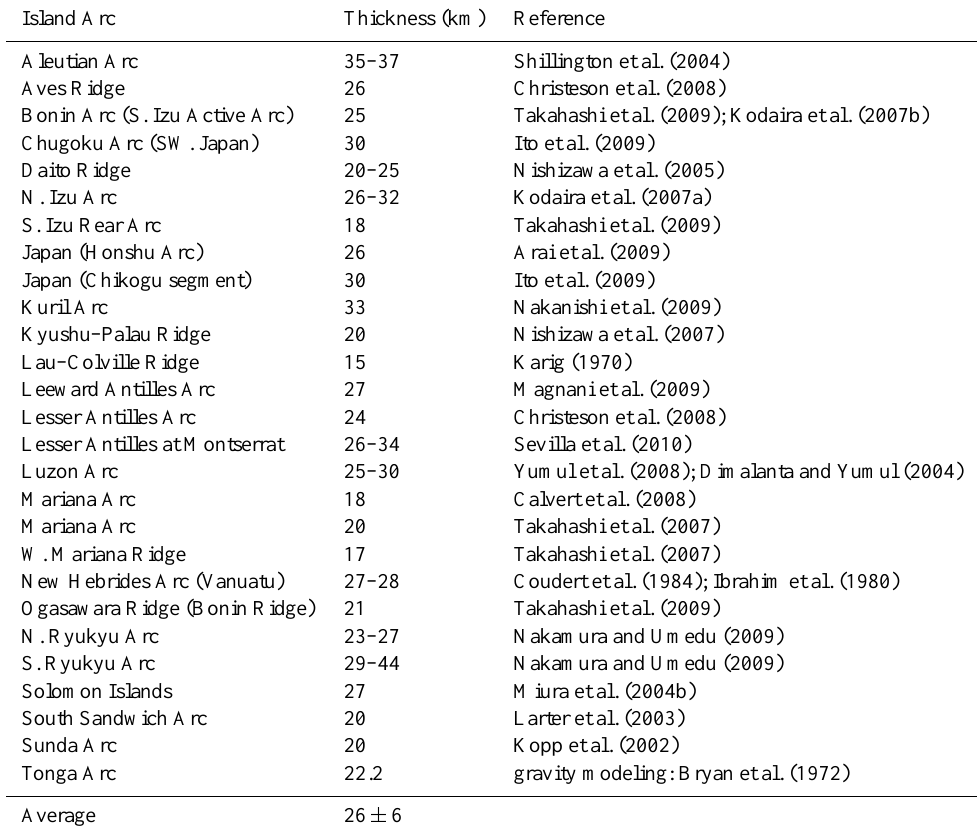
Table 1. Island arc crustal thicknesses including the crust mantle transition layer (CMTL). All thicknesses are taken from seismic interpre- tations except for the Tonga Arc, which was derived by gravity